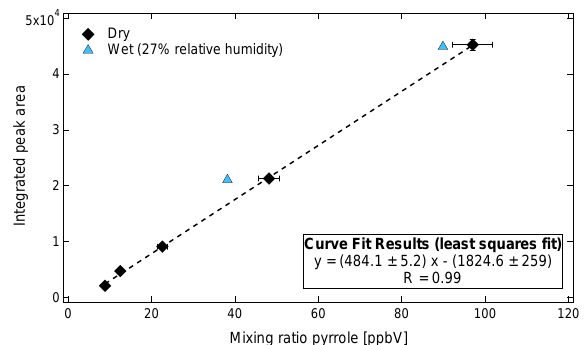
Dry Wet (27% relative humidity)